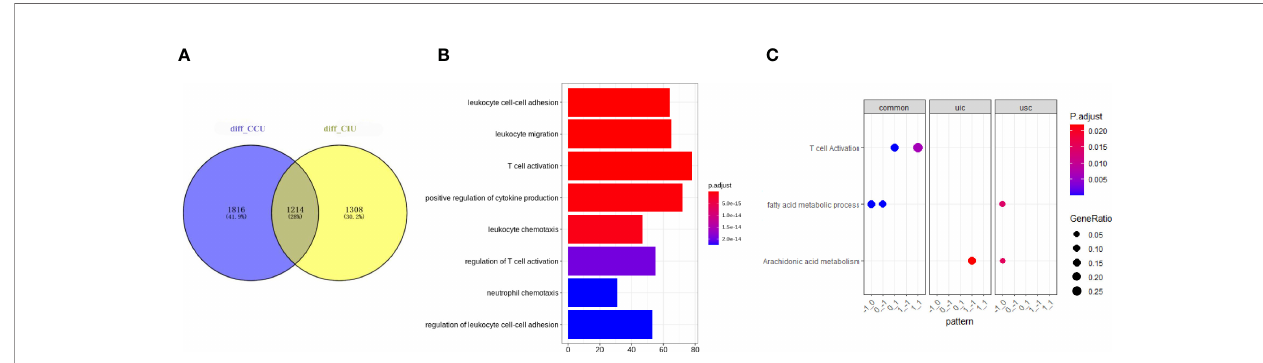
FIGURE 3 | Common and speci fi c functions in CIU and CCU progression patterns. (A) Venn plot showing the number of genes in the same or different modules in the CIU and CCU groups. (B) Gene ontology enrichment of genes with common expression patterns in CIU and CCU groups. (C) Functional analysis of genes in each group. Pattern is referred to as gene modules. CIU (from healthy to IRI-induced AKI to fi brosis) or CCU (from healthy to cisplatin-induced AKI to fi brosis), genes in this pathway are speci fi c to CIU or CCU, respectively; Common, genes in this pathway are shared in the same module of CIU/CCU. The total differential data can be found in Supplementary CSV